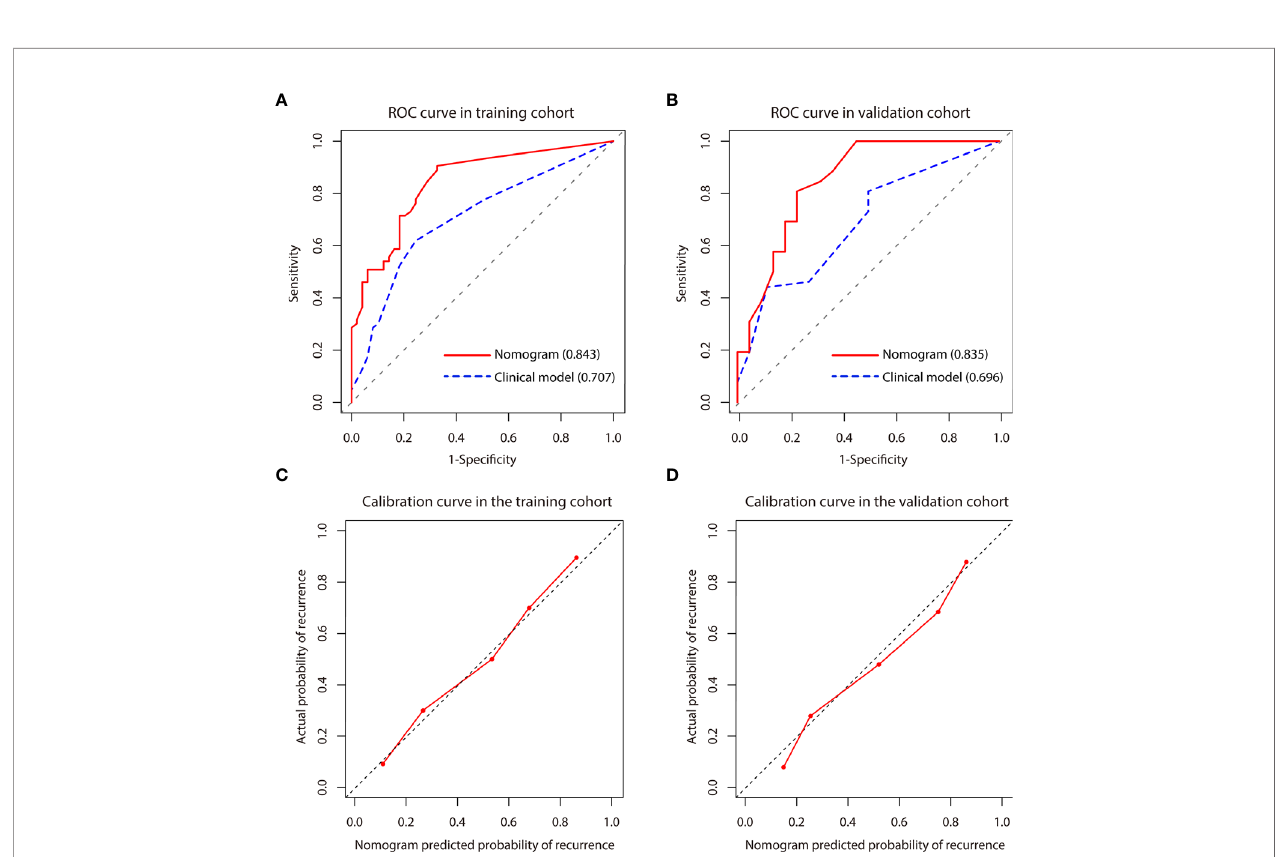
FIGURE 5 | (A, B) Comparison of receiver operating characteristics (ROC) curves for predicting early recurrence between nomogram and clinical model in the training and validation cohort. The clinical model included AFP level and tumor number. (C, D) Calibration curve for the nomogram in the training and validation cohort. Calibration curves depict the agreement of the model between the predicted risks of early recurrence and the actual observed recurrence. X-axis represents the predicted probability of early recurrence. Y-axis represents the actual early recurrence, and the diagonal dashed line indicates the optimal prediction by a perfect model. The red solid line represents the performance of the nomogram, and the closer the red line is to the diagonal dashed line, the higher the prediction accuracy of the model.